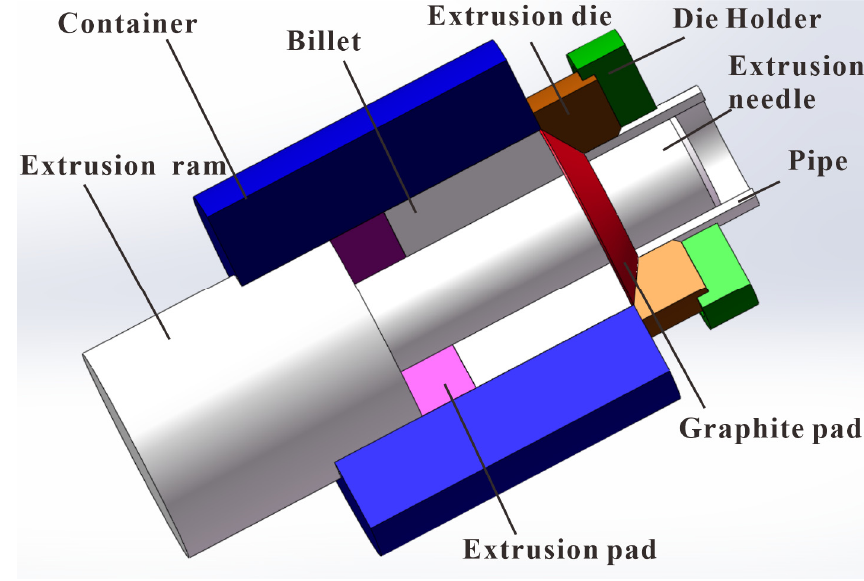
Figure 8. A12 aluminum alloy pipe extrusion diagram.